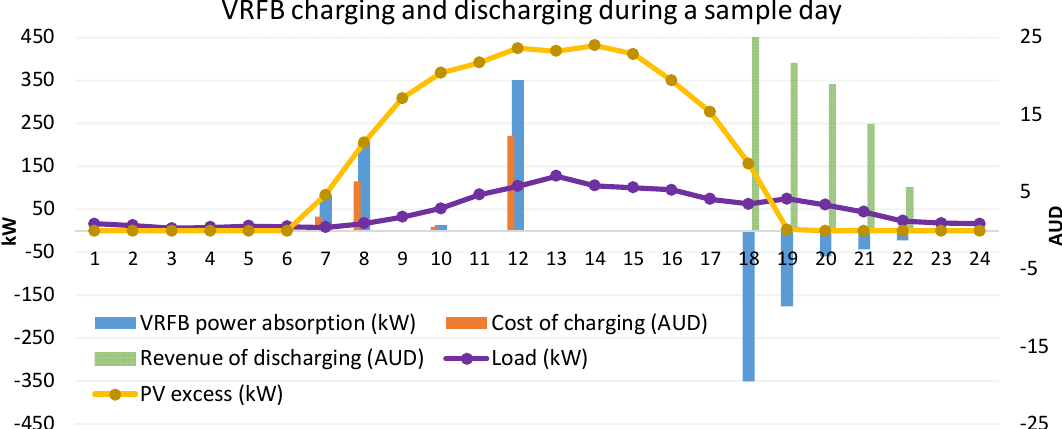
Figure 12. The charging and discharging of VRFB during a sample day in Case I.